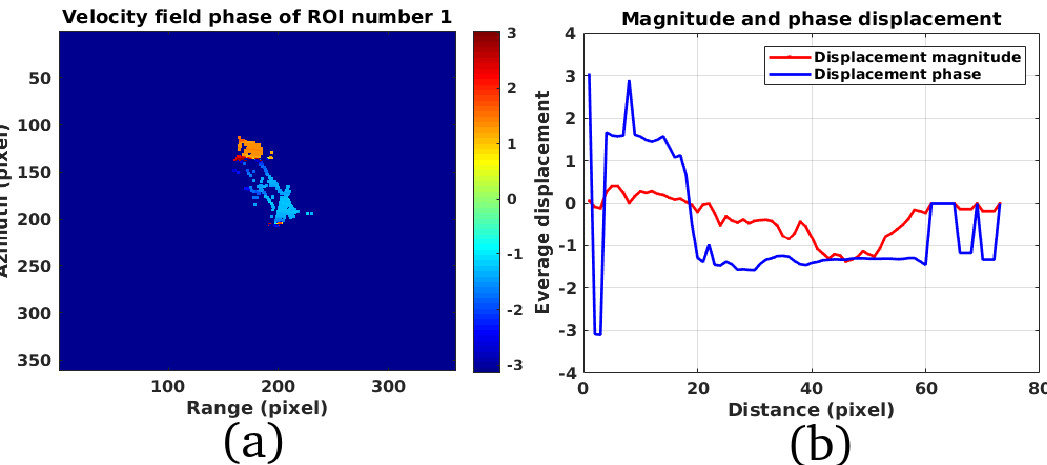
Figure 16. ( a ): Phase component of the range-azimuth displacement. ( b ): Magnitude and phase displacement